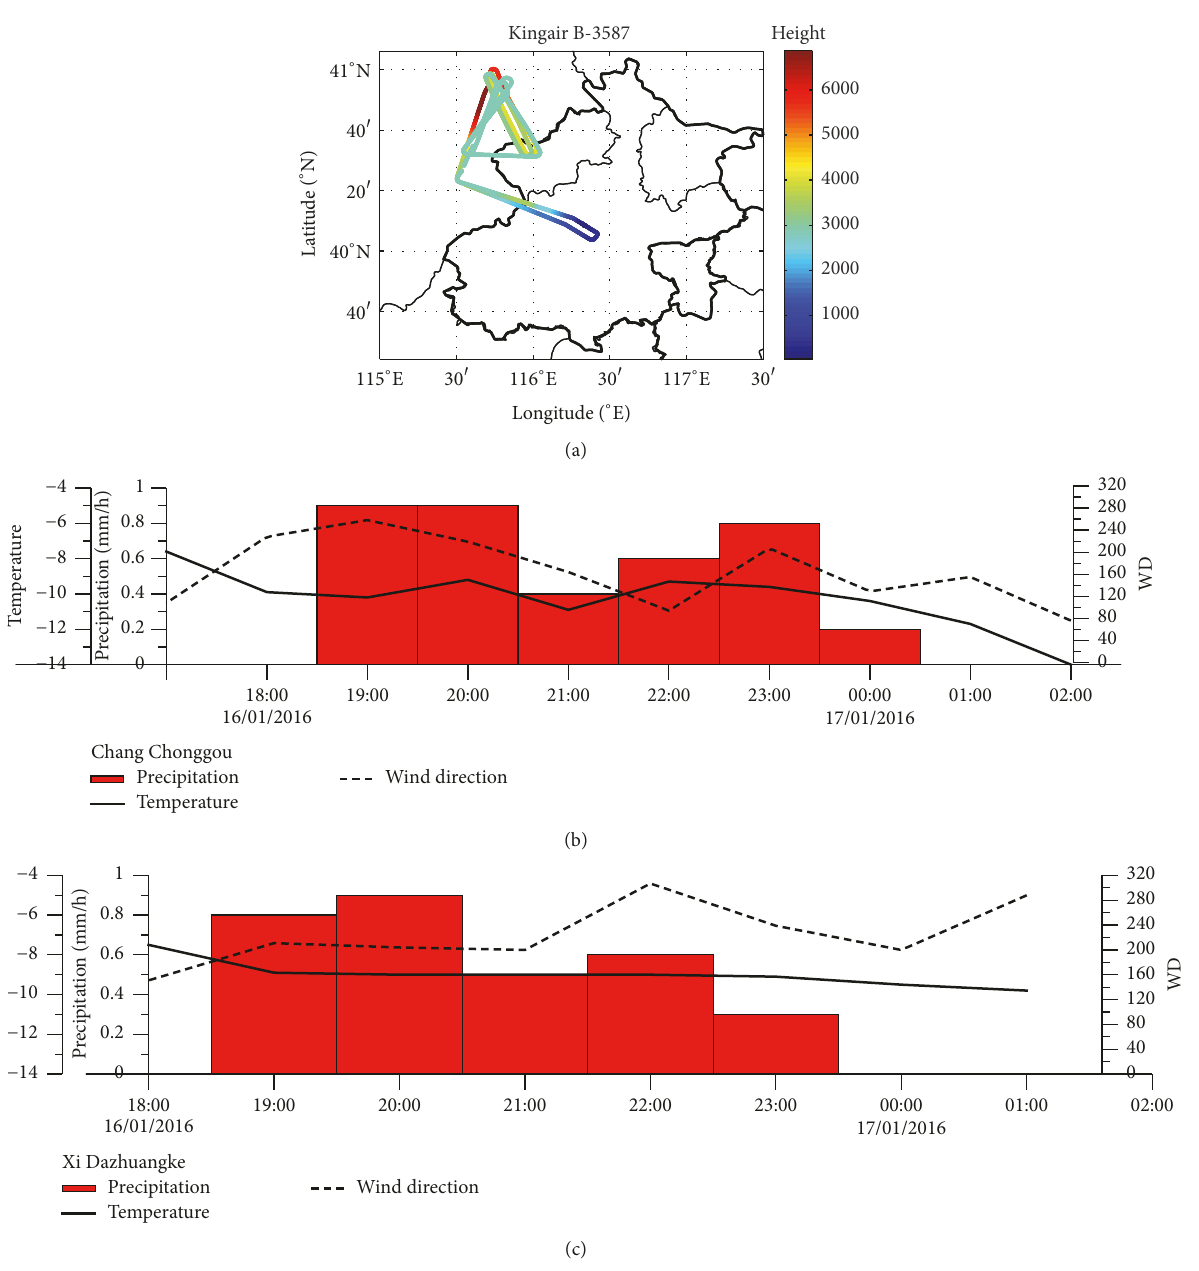
Figure 8: (a) The flight track in the Haituo Mountains under (red circle) upper trough weather condition (case 1); (b) Chang Chonggou weather elements time series; (c) Xi Dazhuangke weather elements time